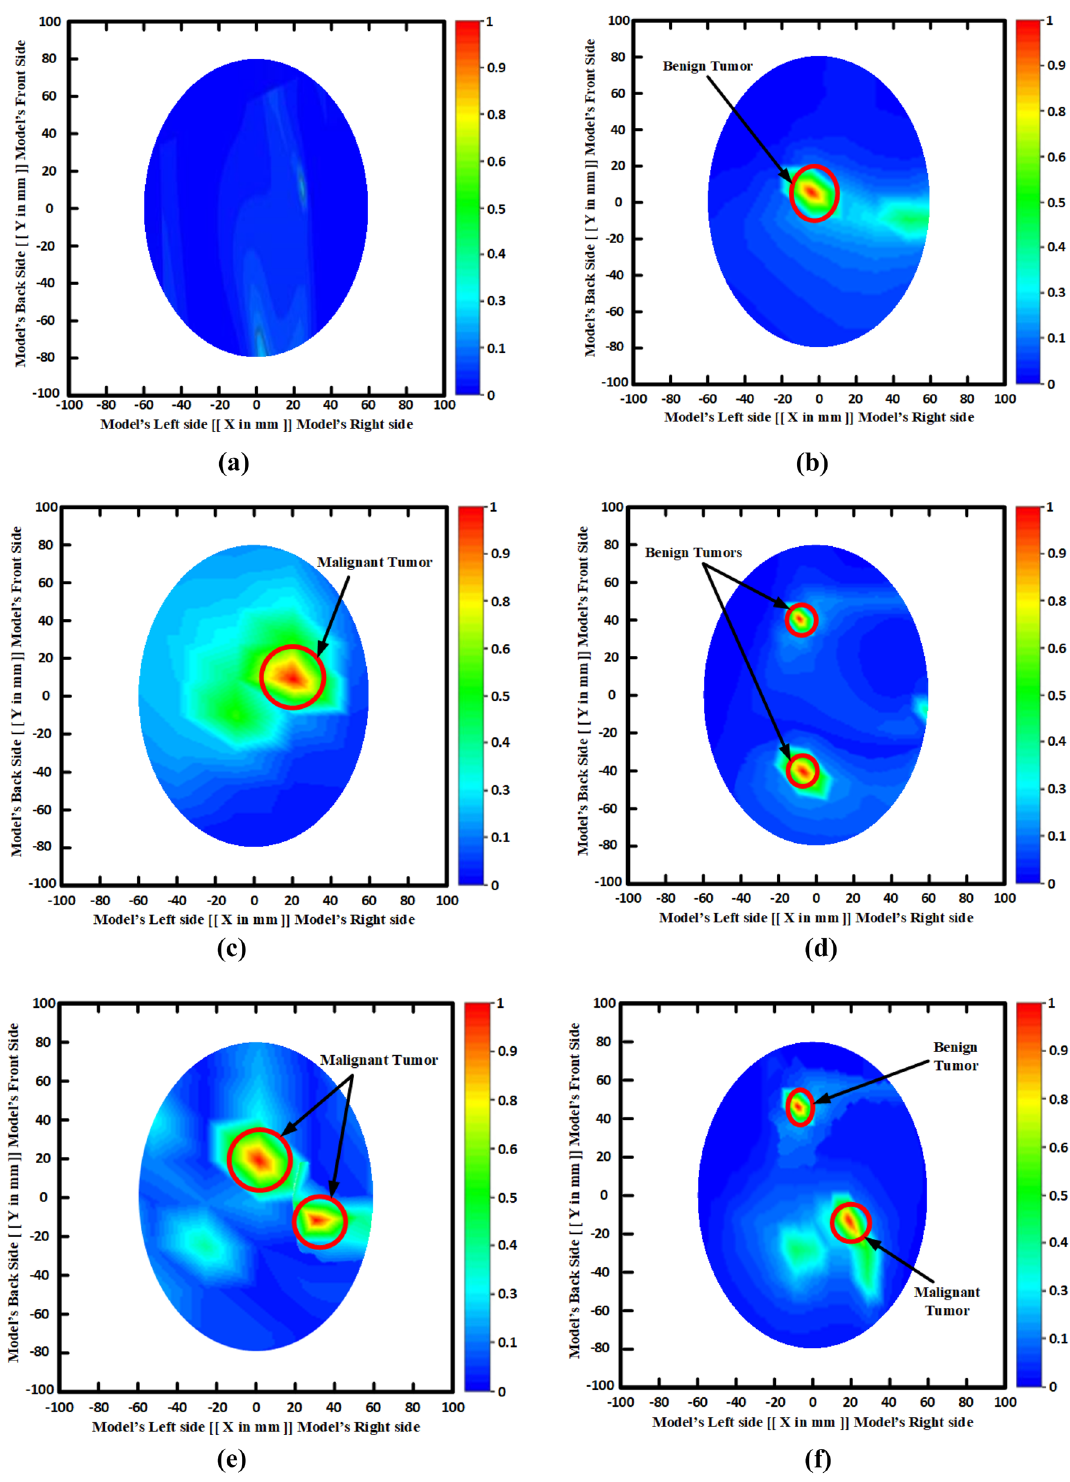
Figure 26. Brain tumor detection results: ( a ) Non-tumor; ( b ) With a single benign tumor; ( c ) With a single malignant tumor; ( d ) With two benign tumors; ( e ) With two malignant tumors; ( f ) With a single benign and a single malignant